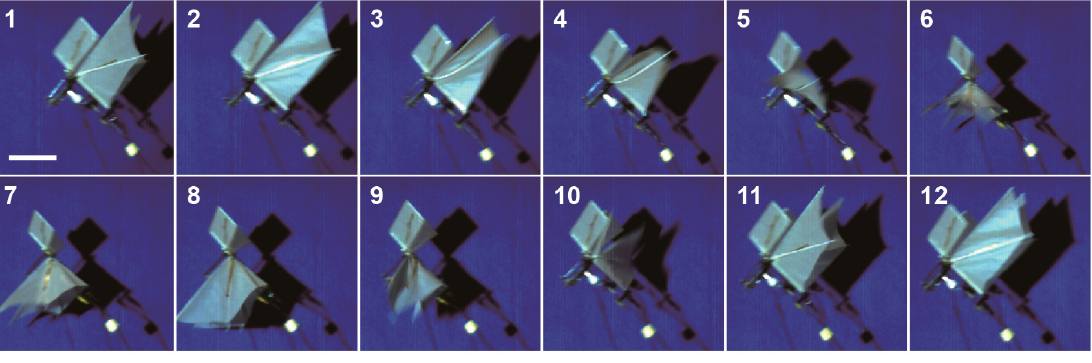
flapping forewings. The interval is 8 ms. The scale bar in ( 1 ) is 100 mm. All images are provided with same scale.